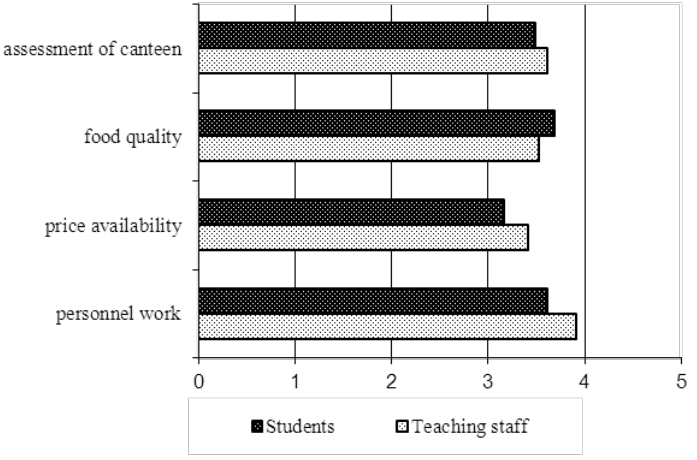
Fig. 1. Assessment of the Kemerovo State University canteen operation, which is visited most often by students and lecturers, by three aspects and upon the whole (by a 5-point scale, where 1 point is very badly, and so on increasingly, 5 points - very good)